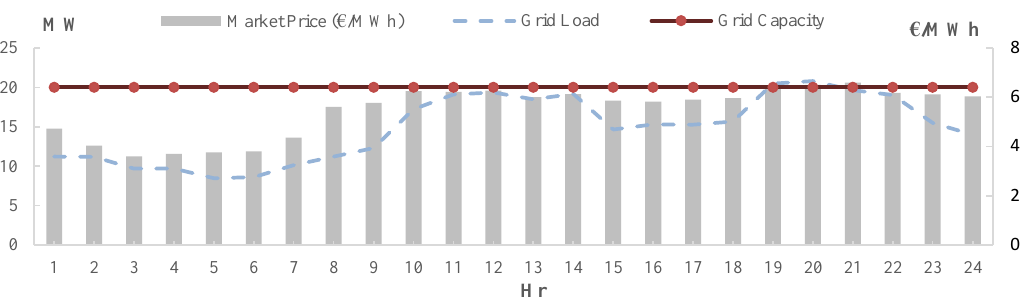
Figure 7. Forecasted load profile (MW) and network capacity (MW) and actual day-ahead market prices (€/MWh).